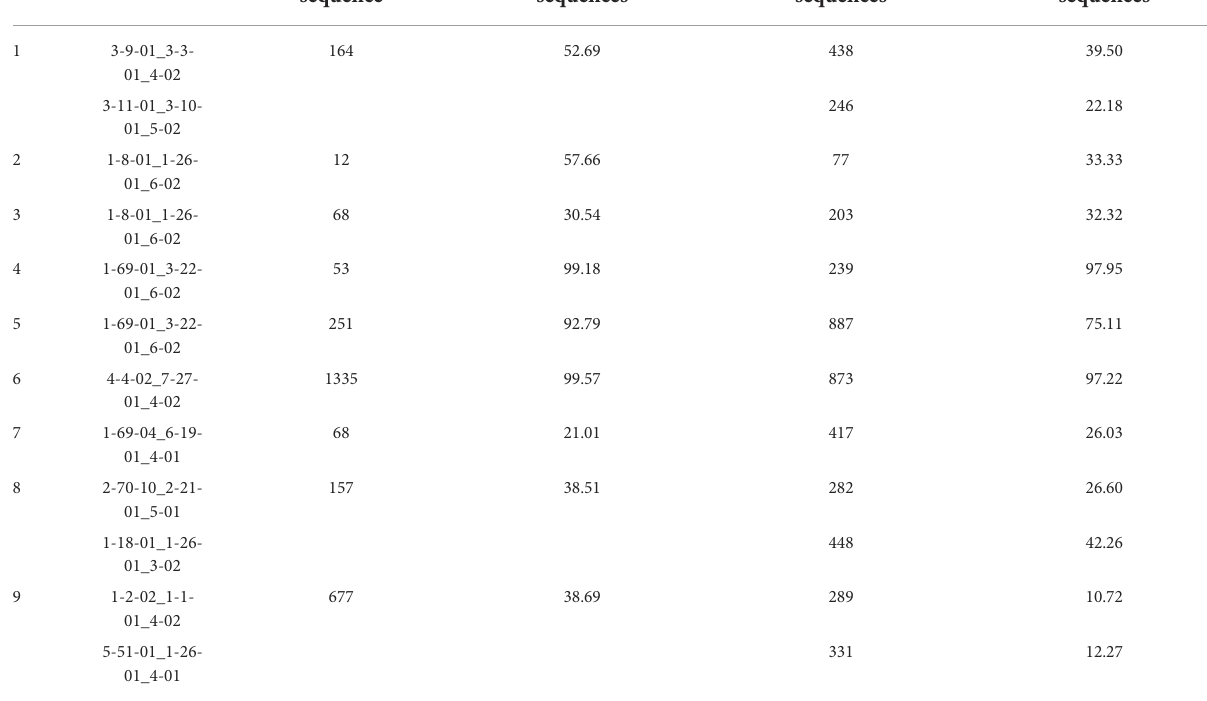
TABLE 3 The dominant clones 1